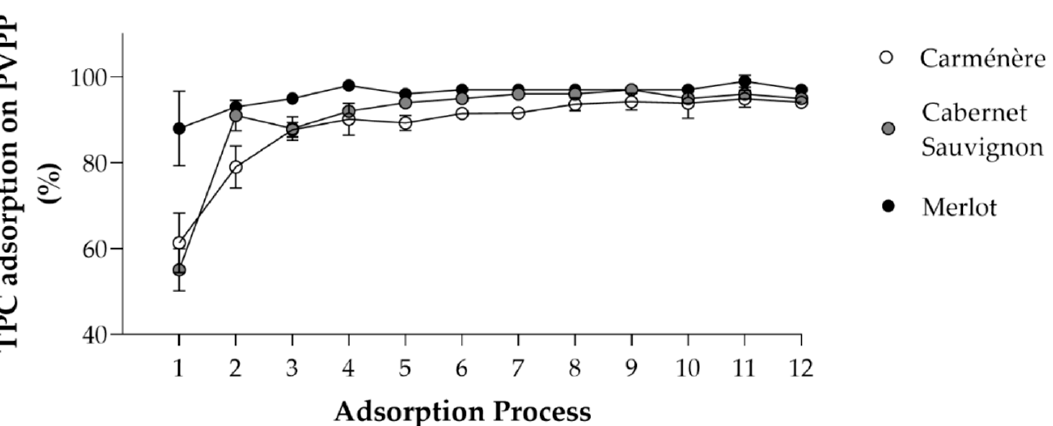
Figure 2. Percentage of TPC from GP extract adsorbed on PVPP. Carménère (white), Cabernet Sauvignon (grey), Merlot (black) extracts. Each adsorption process (1–12) was performed with 3 mL of GP extract. Means and standard deviations are presented for each treatment.